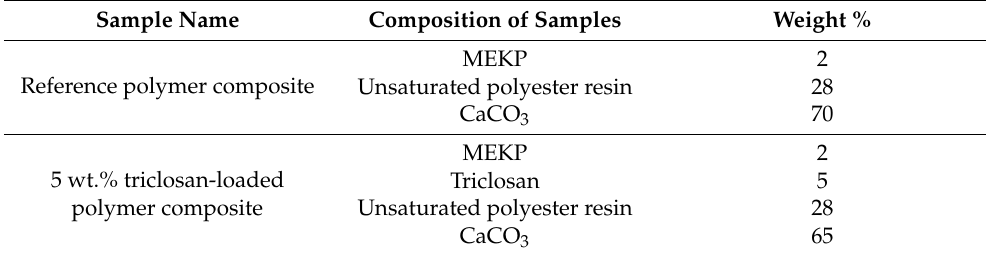
Table 2. The manufacturing of the reference and triclosan-loaded polymer composites.